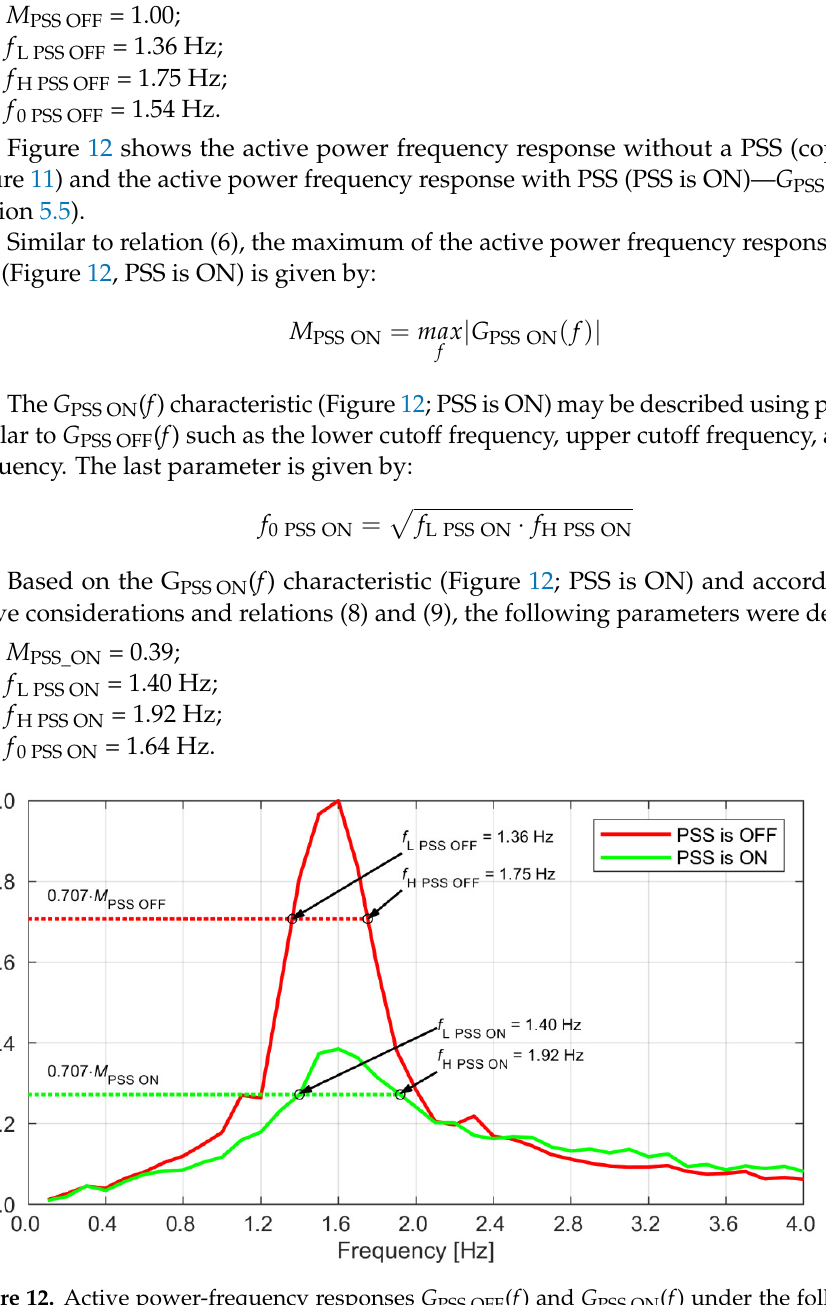
Figure 12. Active power-frequency responses G PSS OFF ( f ) and G PSS ON ( f ) under the following test conditions: PSS is OFF/ON, P g = 382 MW, Q g = 0 Mvar [39].